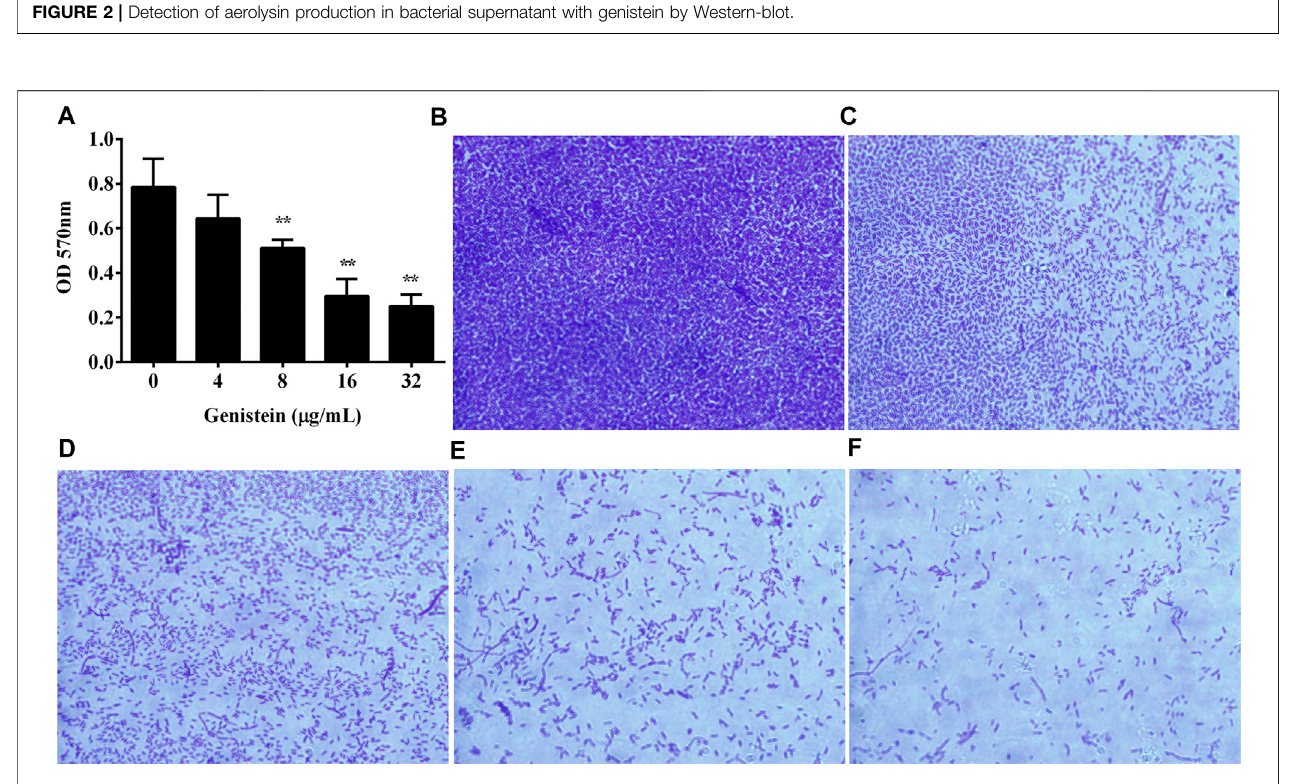
FIGURE3| Inhibitoryeffectsofgenisteinonbio fi lmformation. (A) ,Determinationofgenisteinagainst A.hydrophila bio fi lmformation,Datain Figure3A represented meanvalue ± SDofthreeindependentassays,* p < 0.05and** p < 0.01whencomparedwithdrug-freegroup; (B – F) ,inhibitoryeffectsofgenisteinonbio fi lmformationby microscopicvalidation; (B) ,drug-freegroup; (C) ,co-culturedwith4 μ g/mlgenistein; (D) ,co-culturedwith8 μ g/mlgenistein; (E) ,co-culturedwith16 μ g/mlgenistein; (F) , co-cultured with 32 μ g/ml genistein.